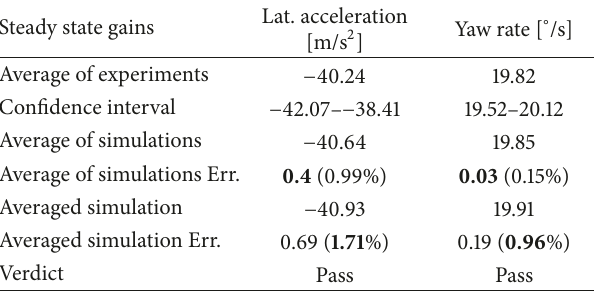
Table 5: Validation results: Maneuver